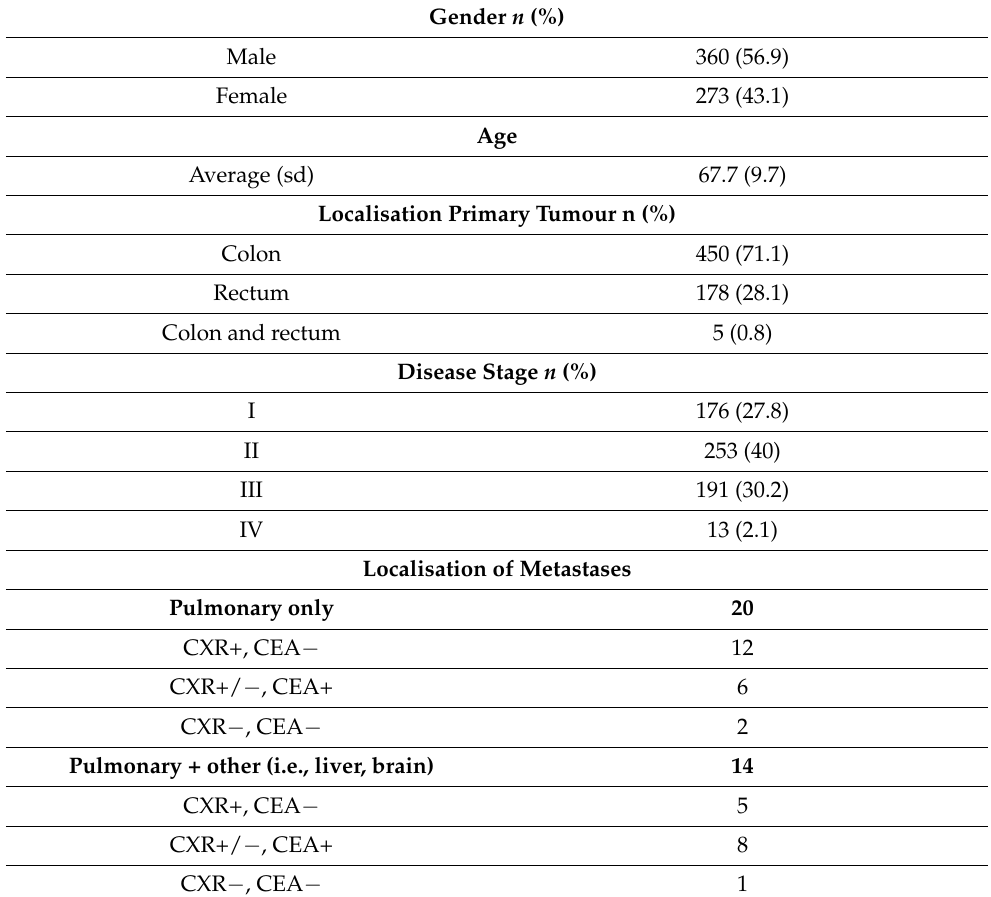
Table 1. Patient characteristics.